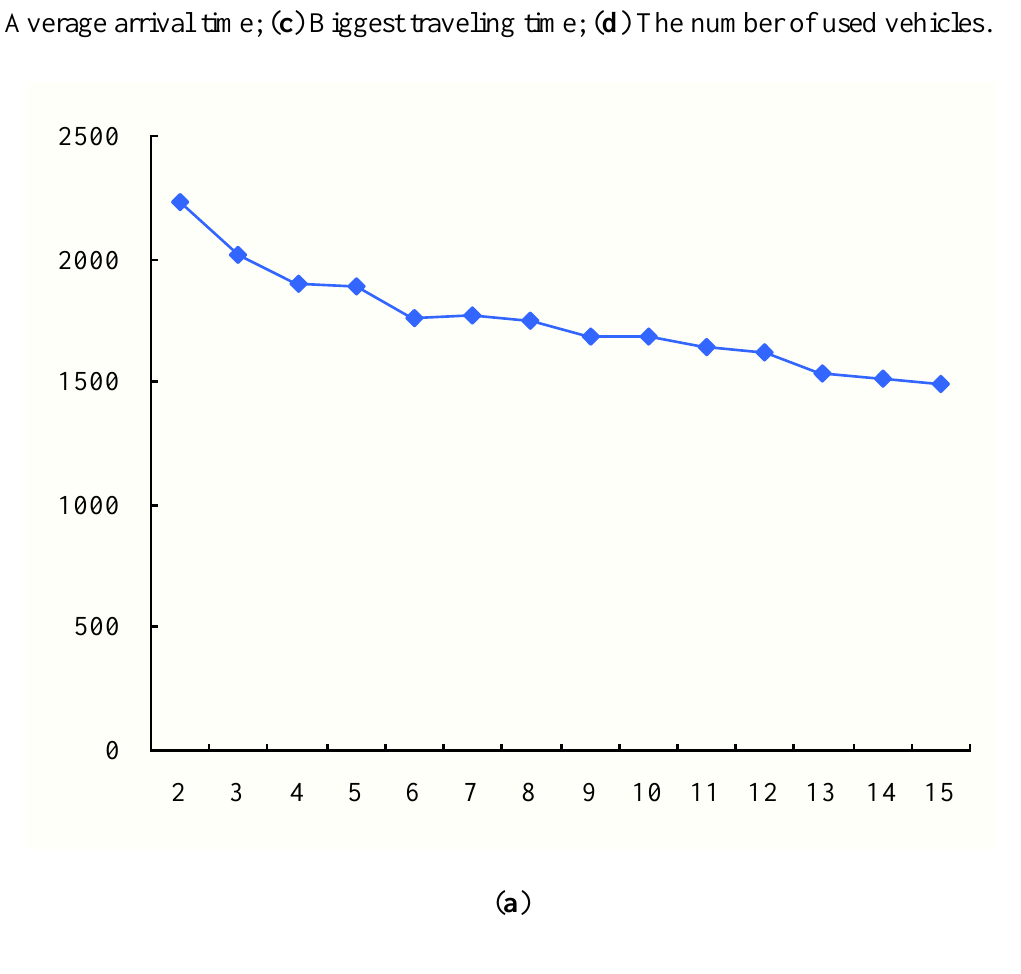
Figure 7. Results with different numbers of TDCs ( Q = 5000). ( a ) Total duration